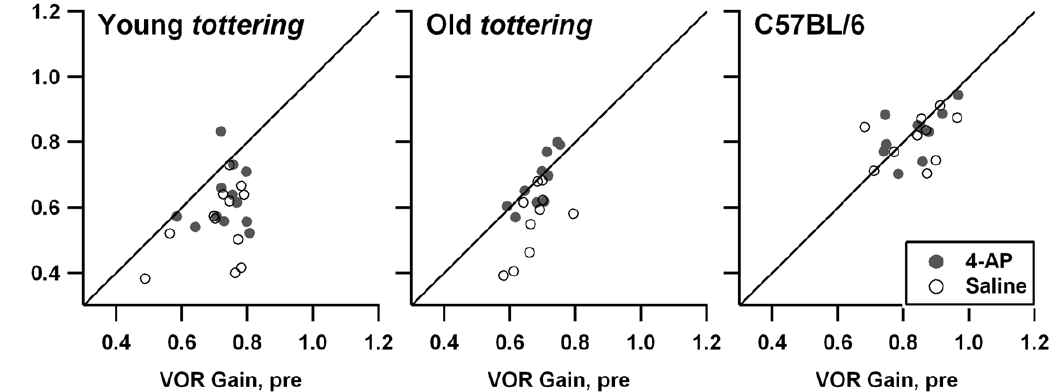
Figure 3. Comparison of vestibulo-ocular reflex (VOR) gain before and after saline or 1.25 mg/kg 4-AP. Symbols and format are identical to Figure 1. 4-AP may have reduced habituation in the elderly tottering cohort.